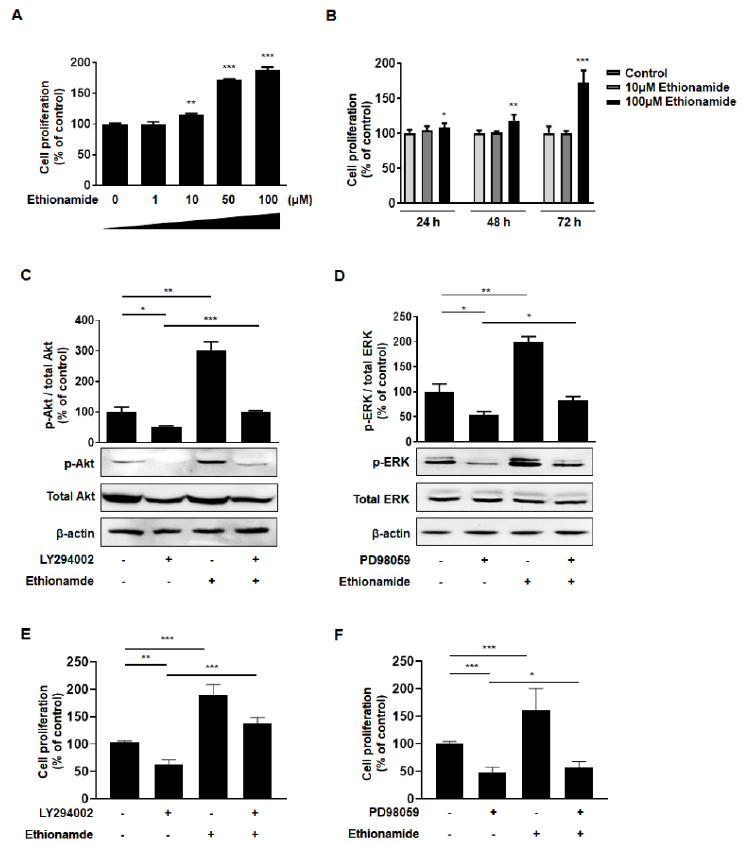
Figure 2. Ethionamide stimulated proliferation of MSCs via activating phosphatidylinositol 3-kinase (PI3K) / Akt and mitogen-activated protein kinase / extracellular signal-regulated protein kinase kinase (MEK / ERK1 / 2) signaling pathways. ( A ) MSCs were exposed to varying concentrations of ethionamide. The proliferation of MSCs was measured by BrdU ELISA after 72 h incubation. ( B ) The proliferation of MSCs was measured by BrdU ELISA after treatment with 10 µ M and 100 µ M of ethionamide for 24 h, 48 h, 72 h. ( C ) PI3K/Akt and ( D ) MEK/ERK1/2 signaling pathways were evaluated by Western blotting. The cells were treated with LY294002 (30 μM), the inhibitors of PI3K and PD98059 (50 µ M), the inhibitors of MEK to suppress signaling pathways. β-actin was used as an internal control. ( E , F ) After the treatment of the cells with ethionamide and inhibitors, the proliferation of MSCs was measured by the BrdU ELISA. The results obtained from three independent experiments were expressed as a percent of untreated control ± SEM; * p < 0.05, ** p < 0.01 and *** p < 0.005 vs. untreated control.